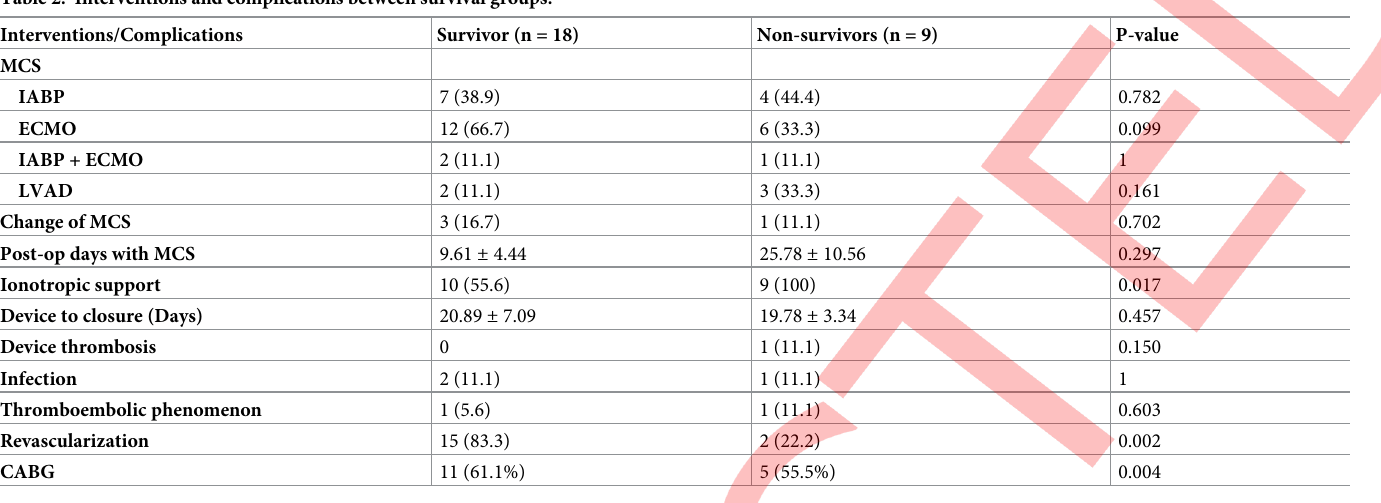
Table 2. Interventions and complications between survival